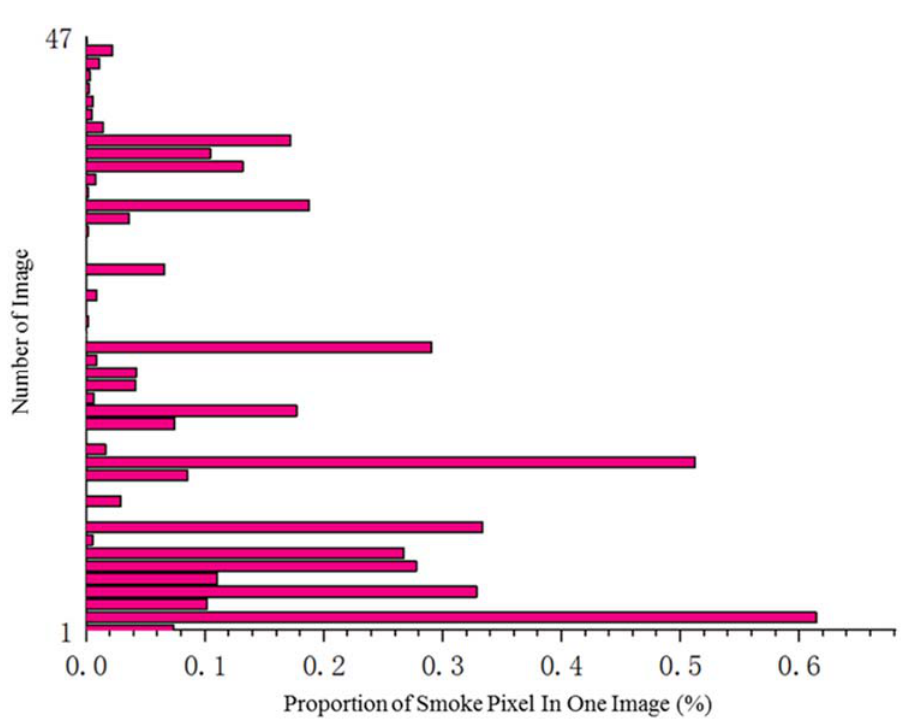
Figure 4. Period of fire occurrence.